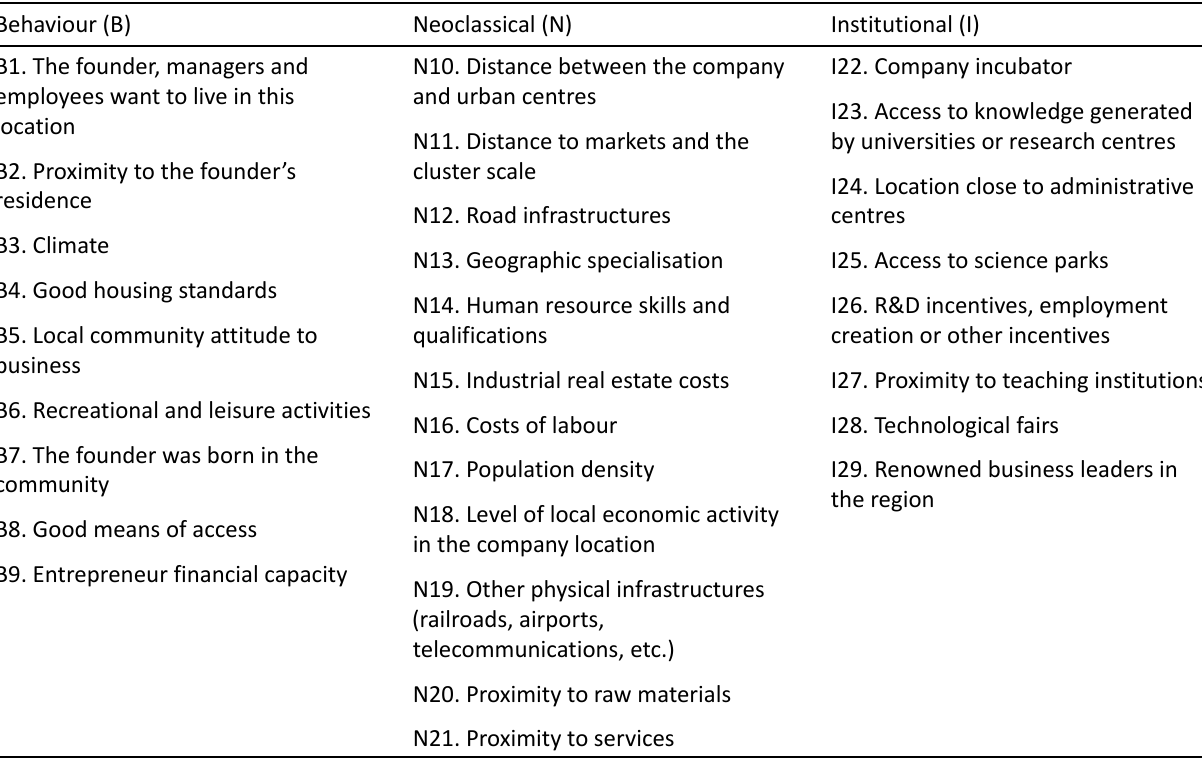
Table 1. Approaches to company location.